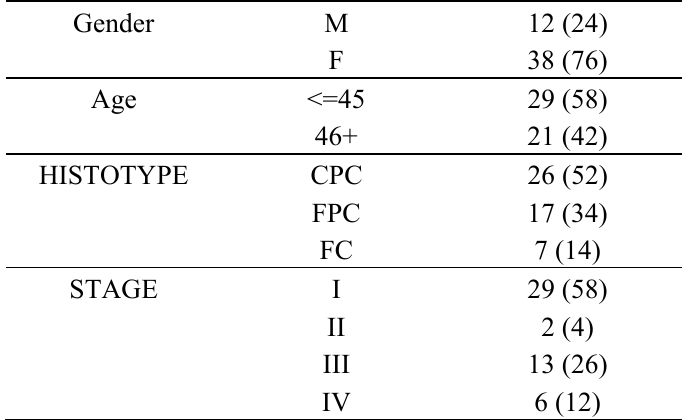
Table 1. Clinic pathological features of thyroid cancer